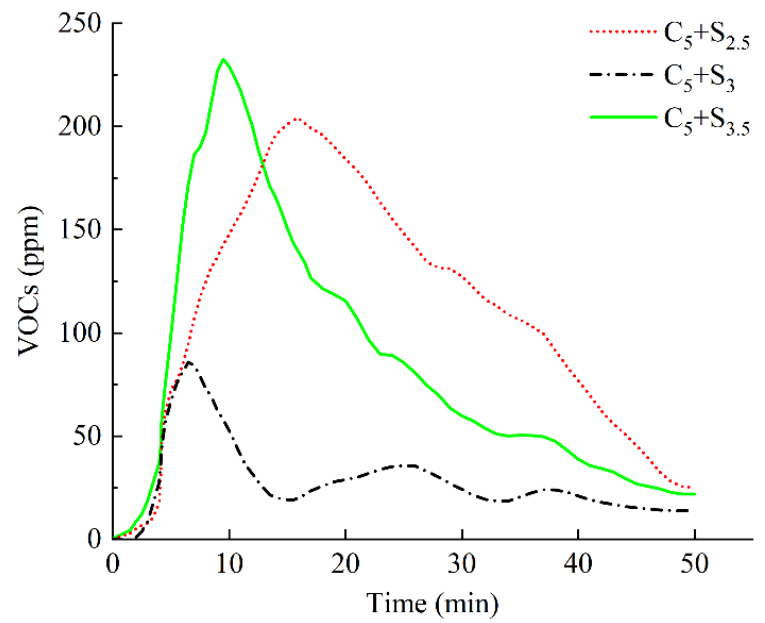
Figure 8. VOCs emission curve of environmentally friendly modified asphalt under different surfactant contents.